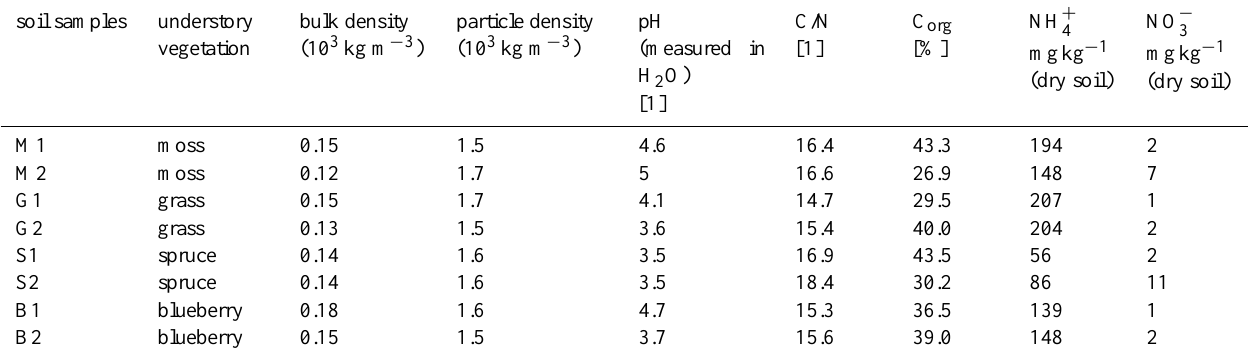
Table 3. Chemical and physical soil parameters from organic soil layers under different understories from Weidenbrunnen research site. NH + and NO − are expressed in terms of mass of N. 4 3